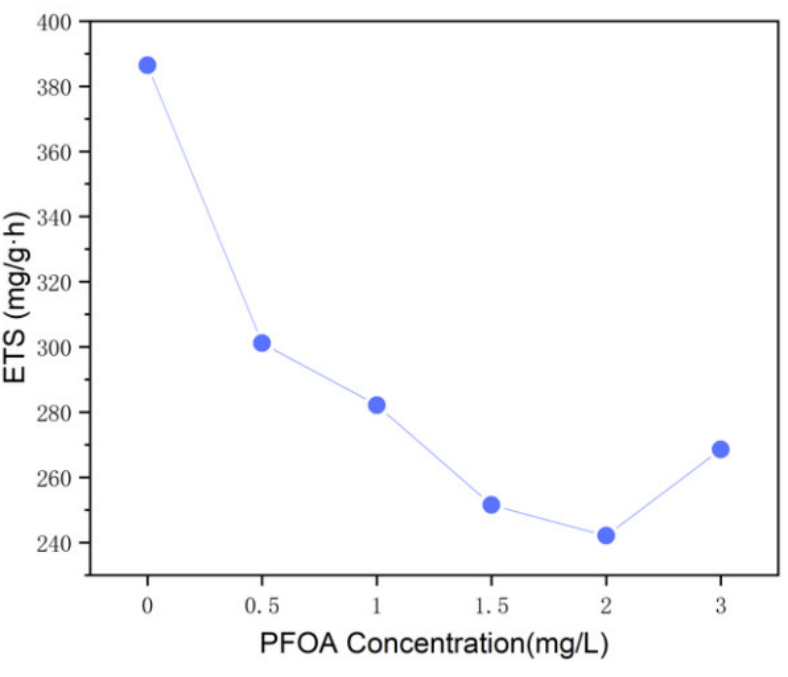
Figure 6. Changes of microbial electron transport activity in AD system exposed to different con- centrations of PFOA.